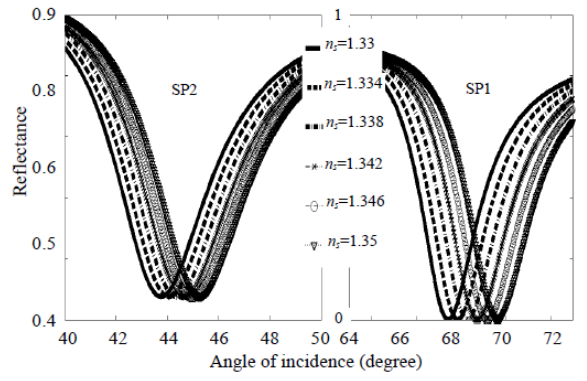
Fig. 3 Calculated p-reflectance with six different refractive indexes, n s of the sensing layer. The other parameters are the same as in Fig.